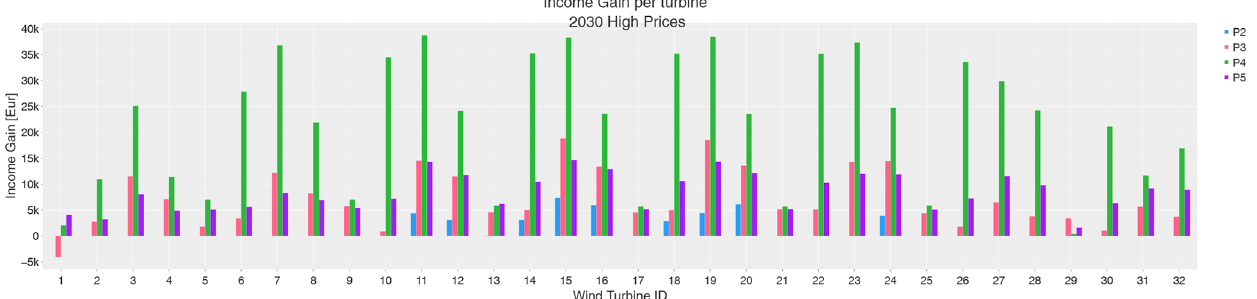
Figure 13. Income gain per wind turbine when using wind farm flow control (WFFC) in simulations with the wind inflow and price information for 2030 as shown in Fig. 1. Each bar shows the difference between the income with WFFC and the income under normal operation without WFFC for one participant. The turbine IDs coincide with the numbering in the farm layout shown in e.g. Fig. 11. Note that P2 investigates the subset layout, and the results (in blue) are available for those 10 turbines